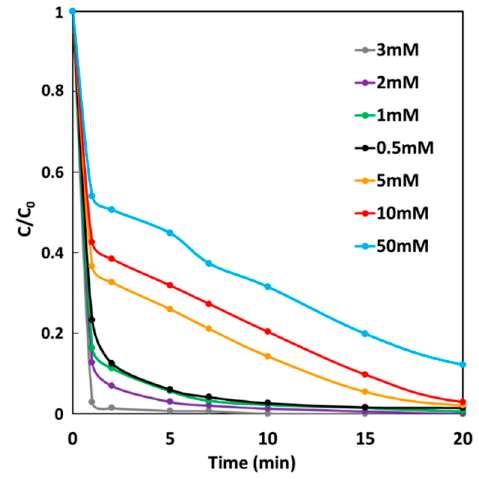
Figure 9. Effect of H 2 O 2 concentration on the degradation of MG dye during the GF process.